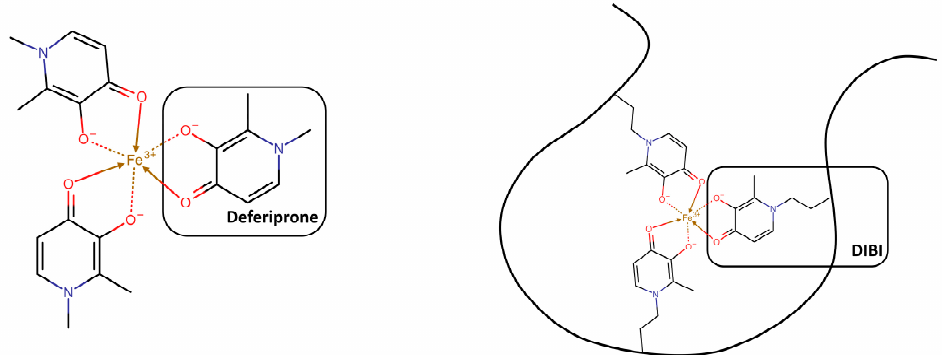
Figure 3. Schematic representation of Deferiprone (Ferriprox ® ) and DIBI in their iron-bound forms (adapted from [249]). The chemical structures were drawn with Chemicalize.